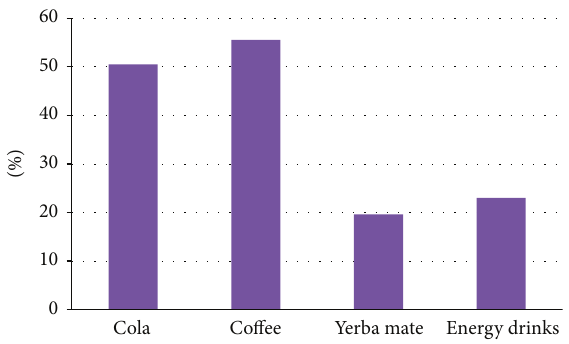
Figure 1: Frequency of stimulant beverages